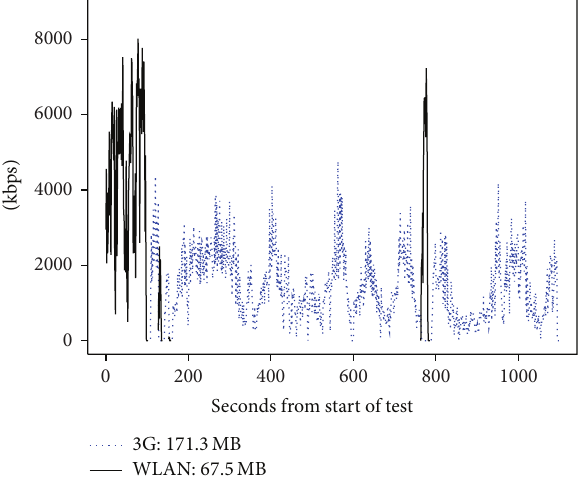
Figure 19: Performance of a reactive algorithm implemented as proposed in Section 6 versus a predictive algorithm using bandwidth geolookups. The experiments are performed using both a 3G scenario and a network switching scenario as described in Section 7. To compare the algorithms on equal terms, one is tested in the real-world setting and the other is simulated using the exact same bandwidth trace. Experiments where the simulated and the real-world algorithms are switched are presented in [10, 11] with similar